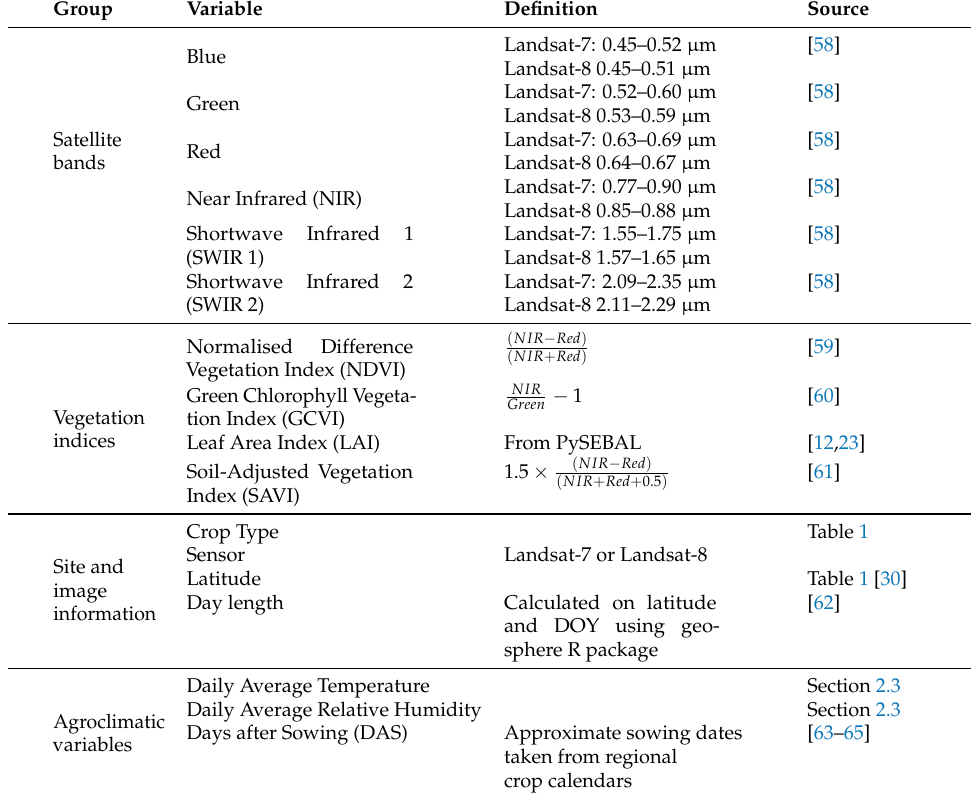
Table 3. Definition of predictor variables used to train predictive models for light use efficiency.